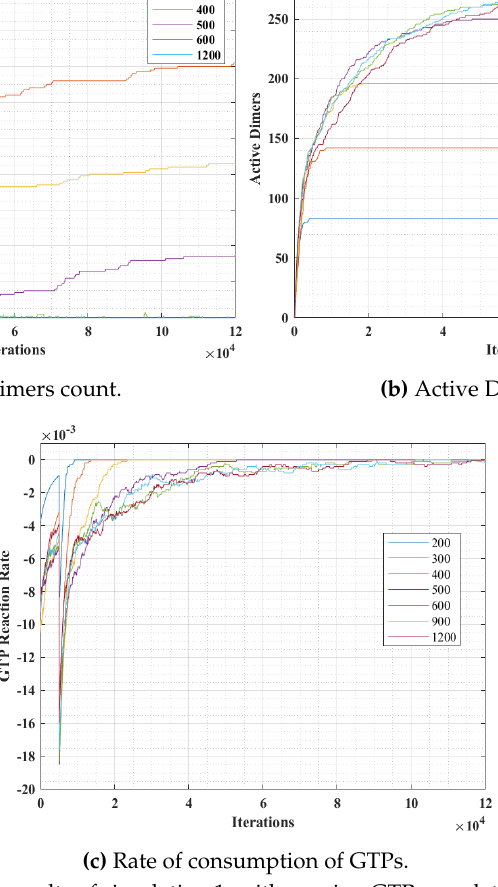
Figure 12. Analysis results of simulation 1, with varying GTP population over